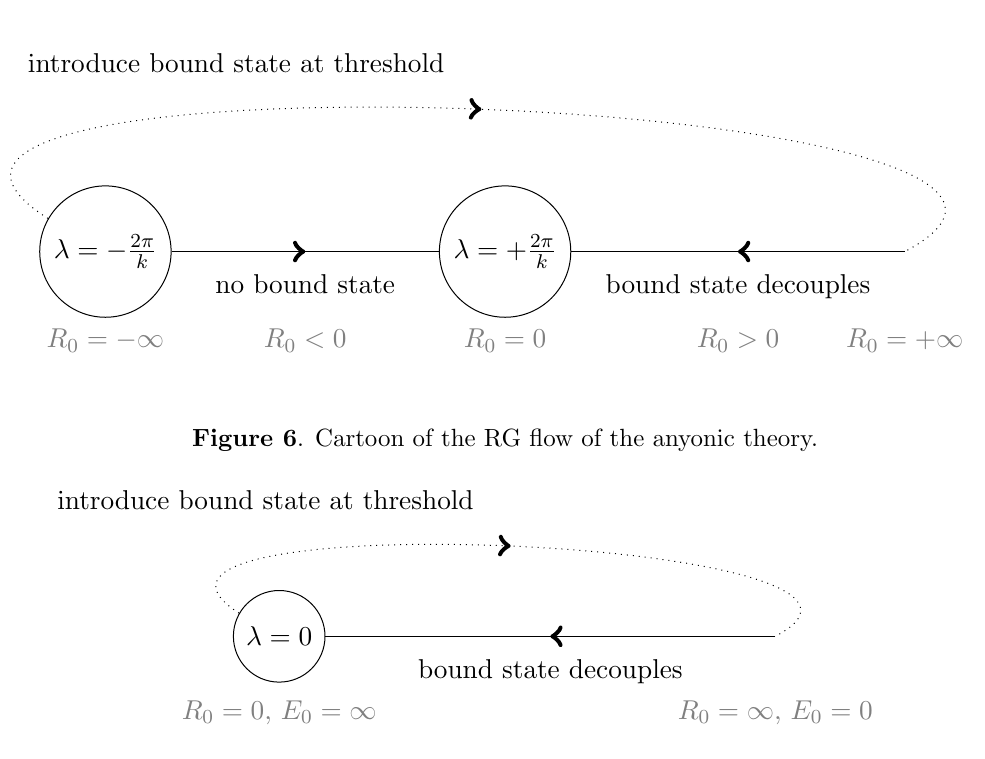
Figure 7 . Cartoon of the RG flow of the bosonic